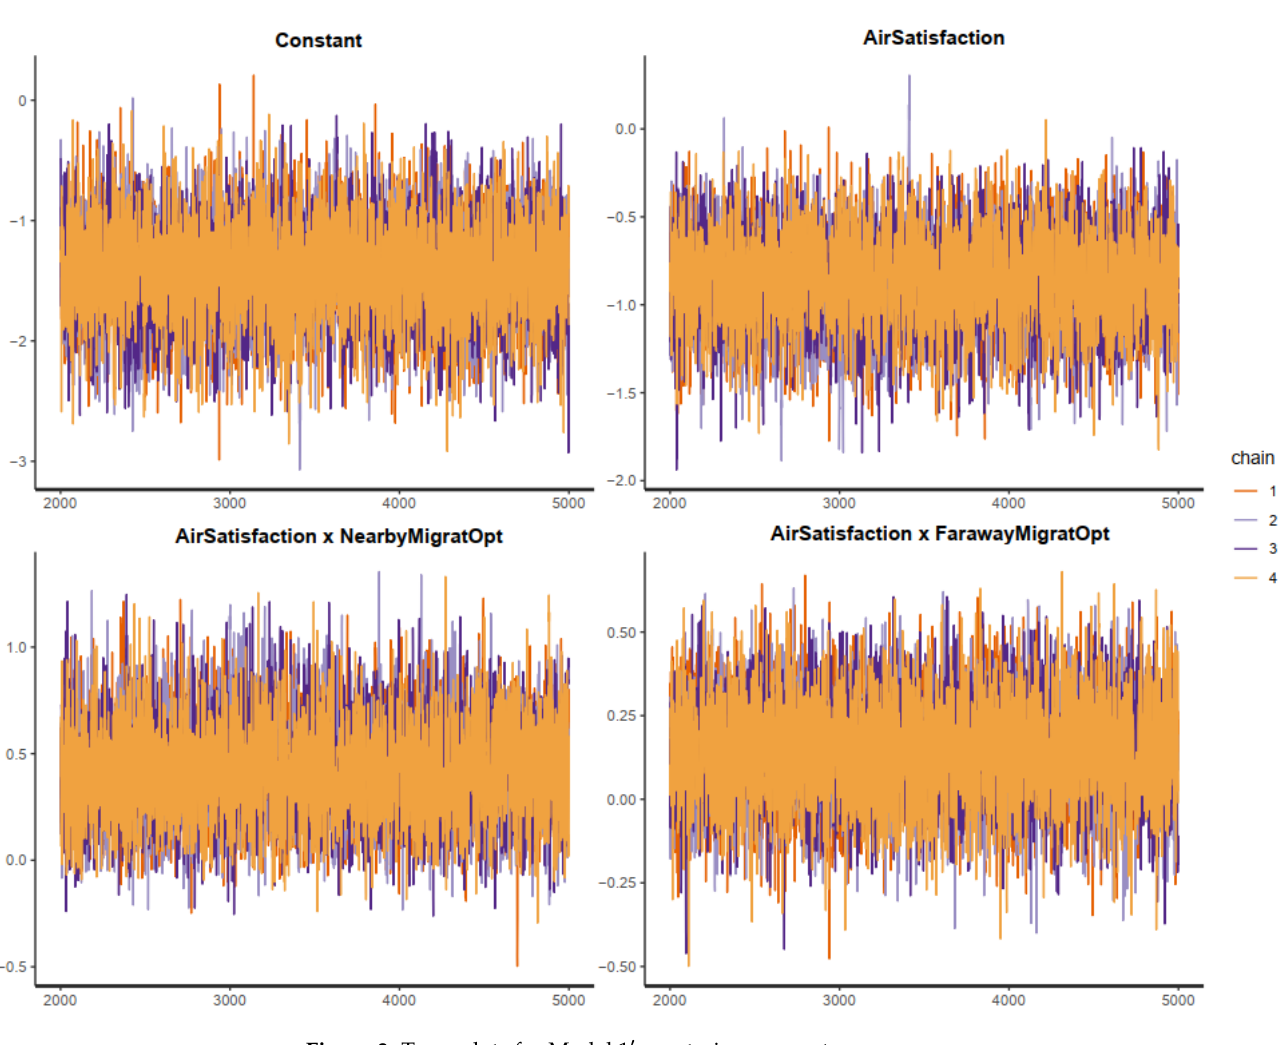
Figure 3. Trace plots for Model 1 ′ s posterior parameters.